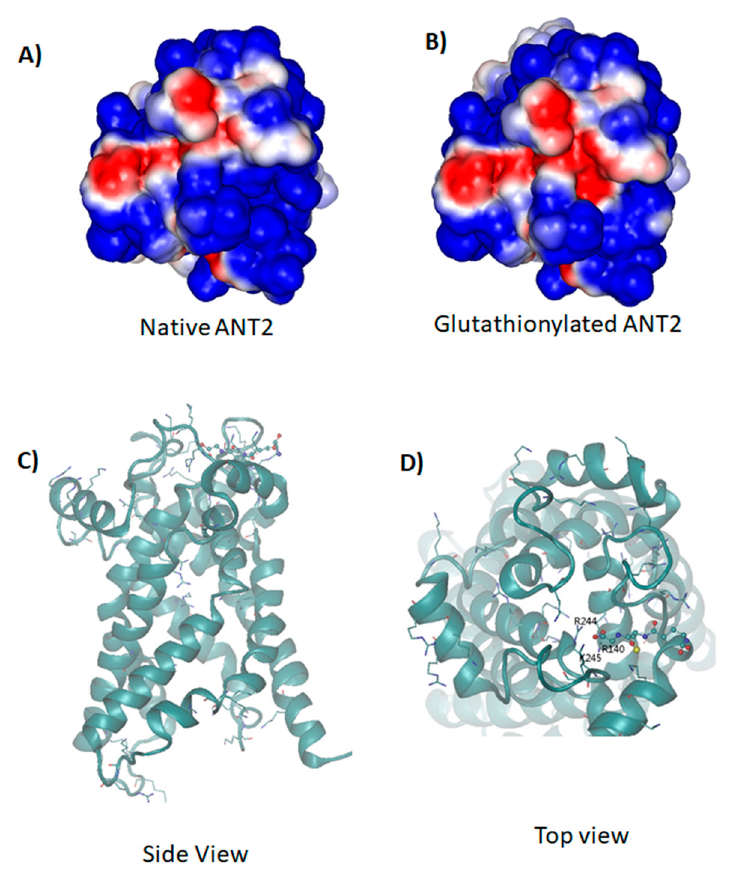
Figure 9. Molecular dynamic simulations of ( A ) native and ( B ) glutathionylated ANT2 ( p .Cys160) show that glutathionylation results in more negative (blue indicates positive potential and red indicates negative potential) electrostatic surface potential at the entrance of the pore, which thus weakens the affinity of ATP/ADP to the ANT2 protein. The cartoon representation [Side view ( C ) and top view ( D )] of the glutathionylated ANT2. The glutathionylated group is shown in CPK, and basic residues (e.g., Arg and Lys) are shown in bonds. The glutathionylated group can form hydrogen bonds to the adjacent basic residues. This may reduce the conformational flexibility of the ANT2 protein, which is required for the translocation of ADP/ATP across the pore. However, the predicted outcome needs further confirmation from experimental evidence.